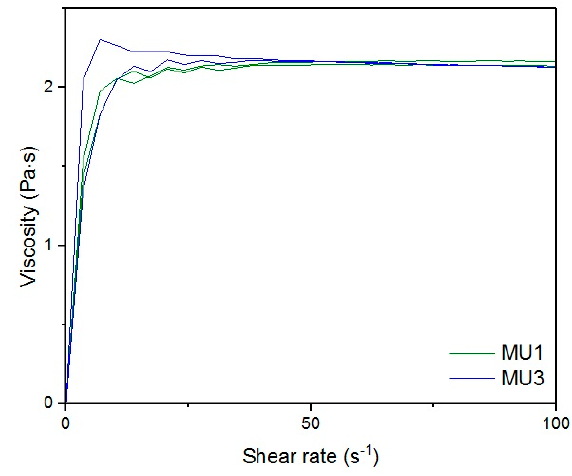
Figure 14. Magnification of the viscosity-shear rate relations for MU1 and MU3 prepolymers at CSR = 100 s − 1 .